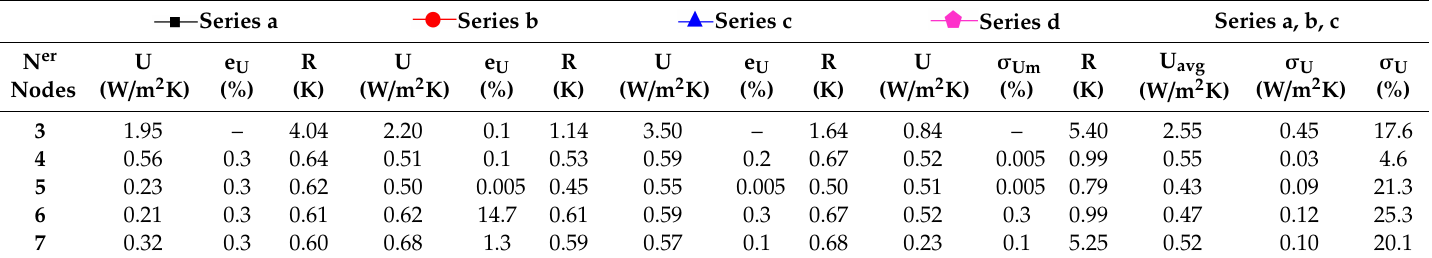
Table 3. Ceiling. U value. Summary of the results using models that include solar radiation. Output: T i . Where e U is the error and R is the average of the residuals given by LORD for each data series.